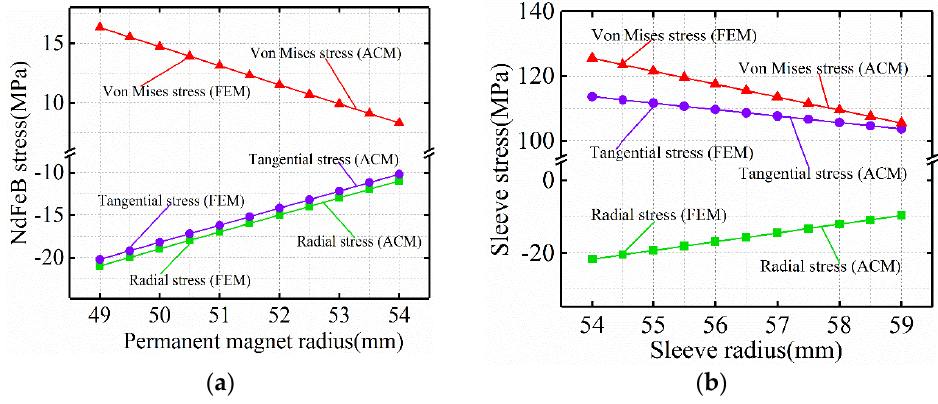
Figure 6. Stress distribution of ( a ) NdFeB-PM and ( b ) sleeve under steady condition. Under steady conditions, the titanium alloy sleeve and FeCo-based PM will not be damaged due to interference fit. For NdFeB PM, in other words, compared with FeCo-based PM, the Von-Mises stress of NdFeB PM is smaller than FeCo-based PM under steady condition.